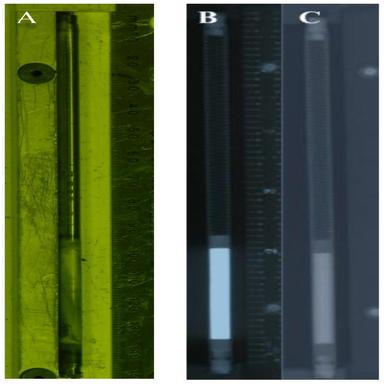
A) Visual examination B) Thermal neutron radiography C) Epithermal neutron radiography of the rodlet. The ruler is in cm.